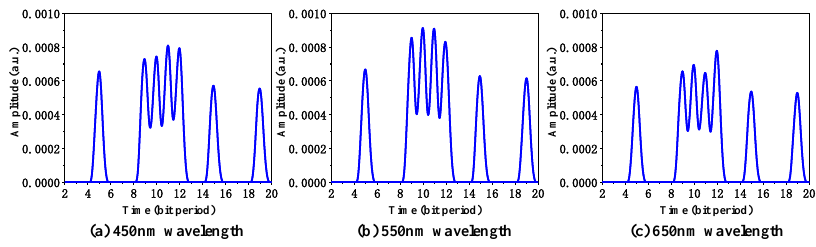
Fig. 3. Receiver signals time-domain waveform diagrams.